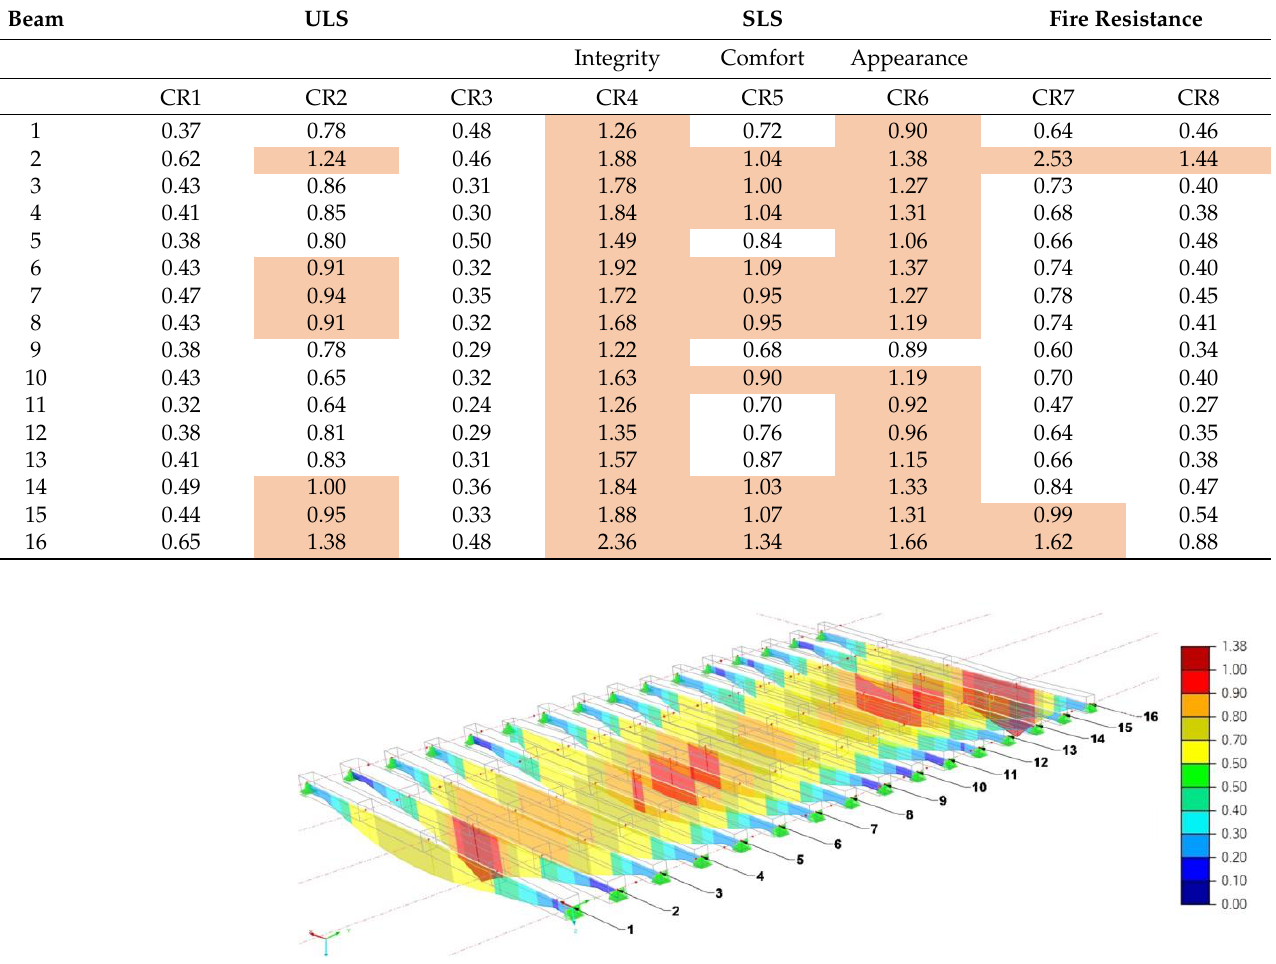
Table 5. Summary of results for each combination and load situation. Cases of almost non-compli-